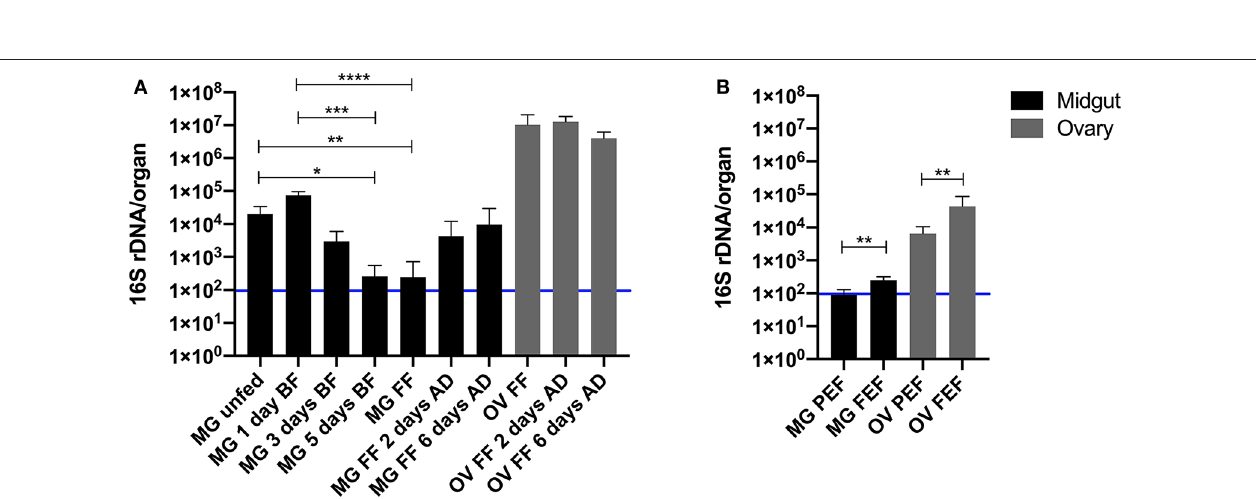
FIGURE 3 | Quantification of the 16S rDNA gene per midgut (black) and ovary (gray) of Ixodes ricinus (A) and Rhipicephalus microplus (B) during blood feeding on a vertebrate host. MG, midgut; OV, ovary; BF, blood fed; FF, fully fed; AD, after detachment; PEF, partially engorged female; FEF, fully engorged female. The number of biological replicates analyzed in each time-point was 7 for I. ricinus and 6 for R. microplus. Error bars indicate standard deviation. The blue line represents the sterility threshold (16S rDNA counts in DNA-free water). Stars indicate statistically significant differences. * p < 0.05; ** p < 0.01; *** p < 0.001; and **** p < 0.0001.